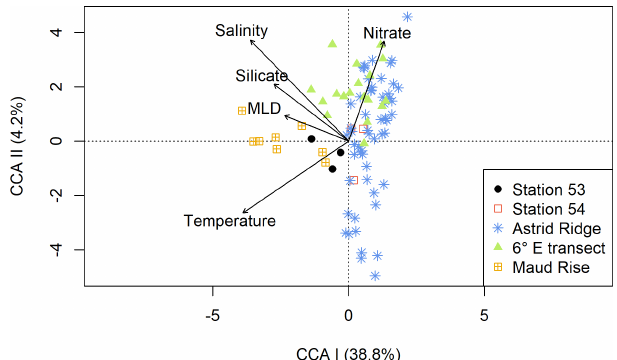
Figure 7. Results of the CCA analysis using microscopy count data at a coarse resolution (see “Methods”) and key chemical and phys- ical oceanographic variables. Samples from the different sampling areas are differentiated by color and symbol; see the legend. Figure 8. Flow cytometry results. Cell abundances of two groups of nanophytoplankton (a, b) and picophytoplankton (c) . MR: Maud Rise, St. 53: station 53, AR: Astrid Ridge, 6 ◦ E tr.: 6 ◦ E transect. Station 54 is marked with a black